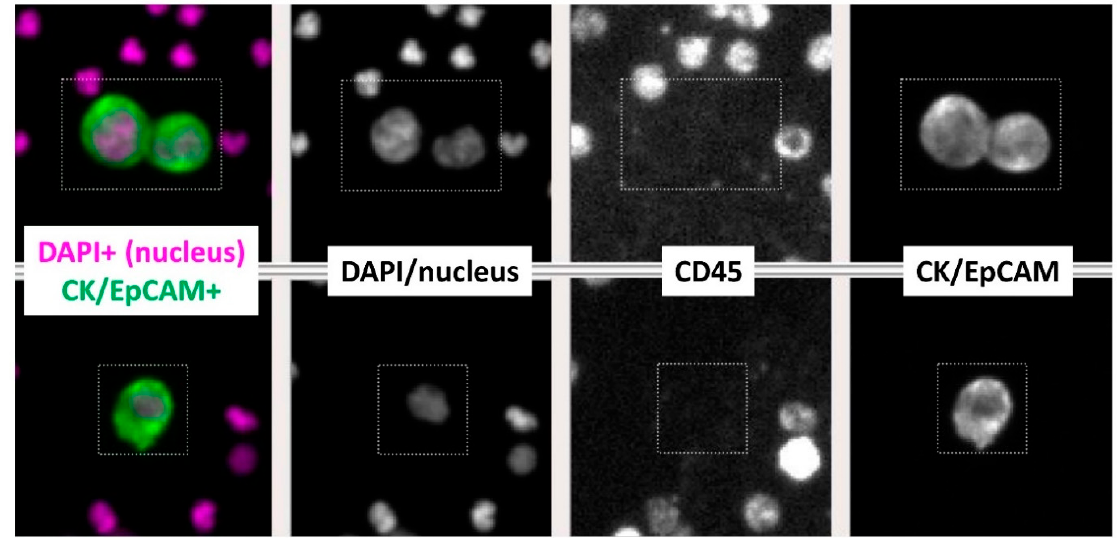
Figure 1. Four-channel fluorescent images of circulating tumor cells (CTCs) detected in NSCLC patients’ blood (7.5 mL). CTCs from two different NSCLC patients are shown, identified as cytokeratin (CK)/EpCAM+ and CD45- cells with DAPI+ nuclei. (Magnification ×10). Table 2. CTC enumeration in control high-risk subjects without cancer and NSCLC patients. N Circulating Tumor Cells/7.5 mL blood p Value Present (%) Mean (±SEM) Median (Range) Smokers without cancer 0.18 (±0.12)